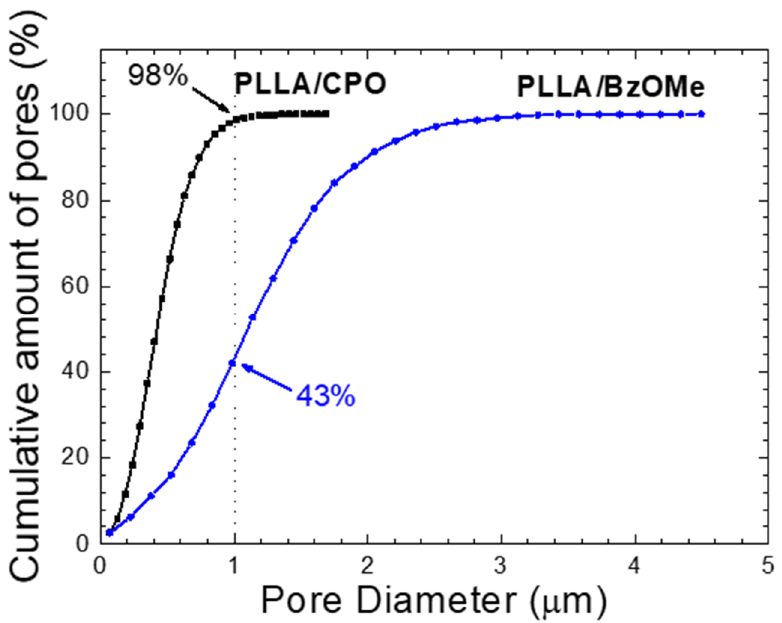
Figure 5. Cumulative amount of pores as a function of pore sizes, obtained by SPIP™ analysis of SEM micrographs reported in Figure 3. Table 1. Specific surface area and volume of pores by N 2 adsorption–desorption